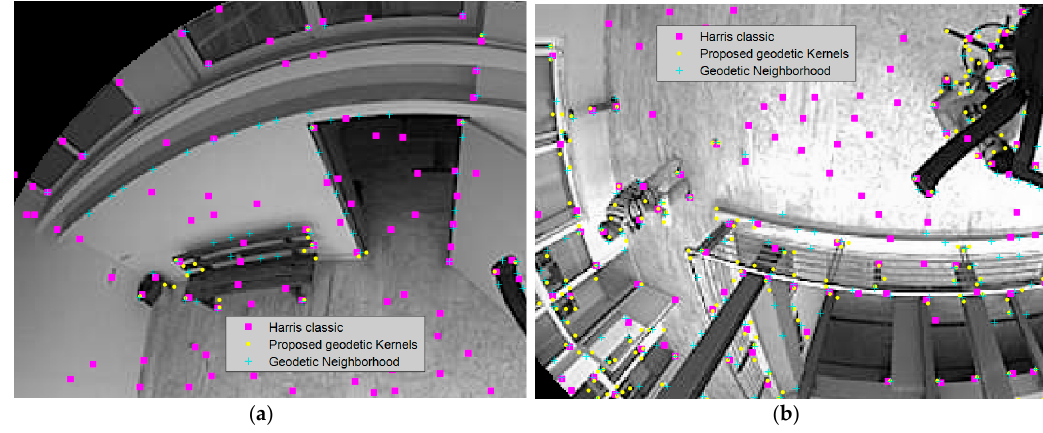
Figure 17. ( a ) and ( b ): Two different parts of the fisheye frame from the result with 500 strongest corner responses, using kernels of size 17 × 17 (color encoding is the same as in the previous Figure).